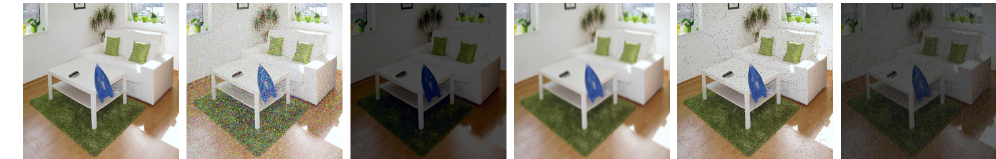
Figure 4. We apply randomly different kinds of effects on synthetic images before the application of the pencil filter. The examples of applied effects are shown from left to right: no effect, Gaussian noise, contrast and illumination changes, motion blur, speckle noise and mixture of all effects.